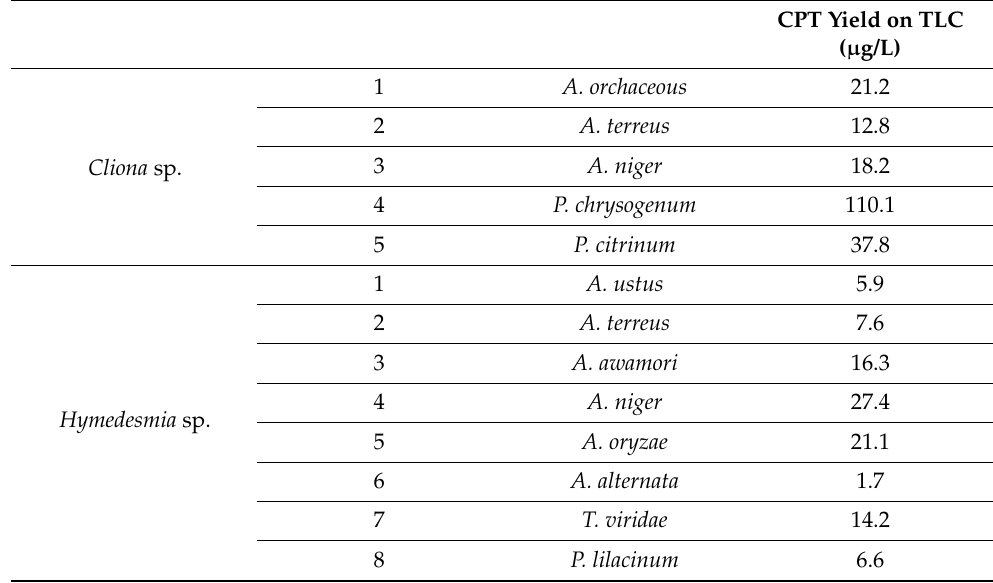
Table 1. Screening for CPT producing endophytes from marine